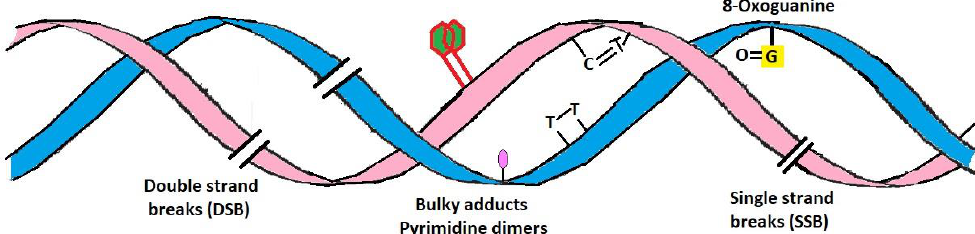
Figure 2. UV-induced direct and indirect DNA damage. Formation of thymine cyclobutane dimers (CPD) and (6-4) pyrimidine-pyrimidone (6-4 PP) photoproduct.